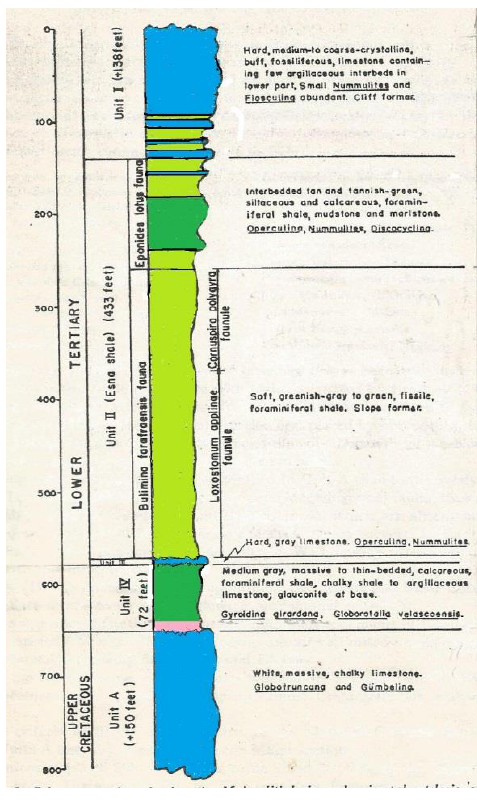
Figure 2: Columnar section of major lithologic and micropaleontological subdivisions of the Maqfi section, Farafra Oasis, Western Desert of Egypt (after LeRoy, 1953)